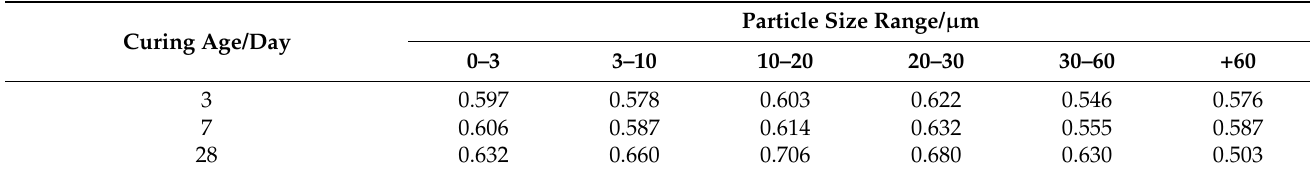
Table 6. Grey correlation between particle group of CGS and strength activity index.